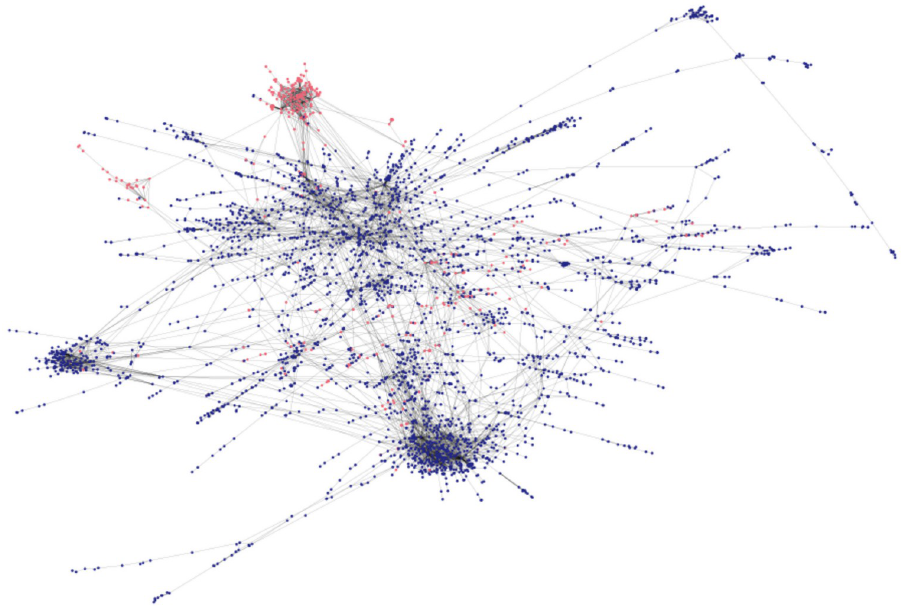
Fig 4. Representation of the repeated mutual interaction graph from 2013–2016. Profiles frequently interact with others who share their own stance, and antivaxx profiles are localized in relatively few, tightly nit clusters. Profiles with and anti- and provaccine stances are illustrated in red and blue, respectively. Only the giant conected component of the interaction graph is depicted.